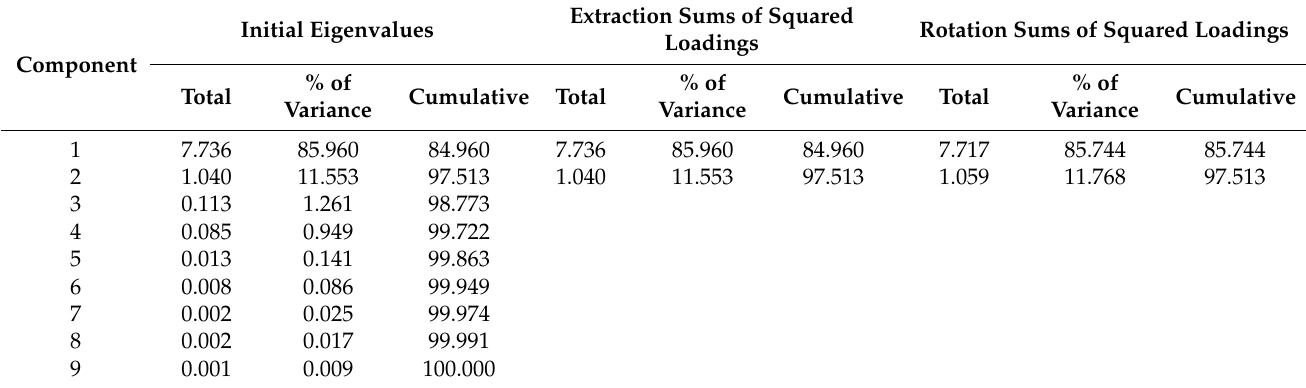
Table 5. Factor analysis of principal component characteristic values and contributions in